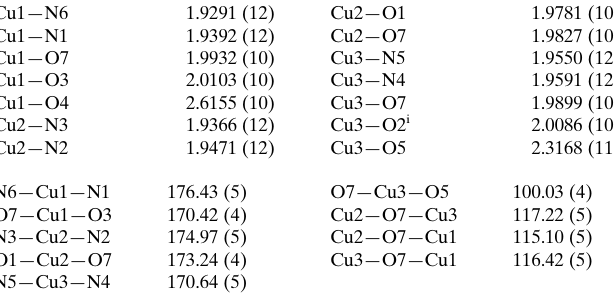
Table 1 Selected geometric parameters (A˚ , (cid:5) ).